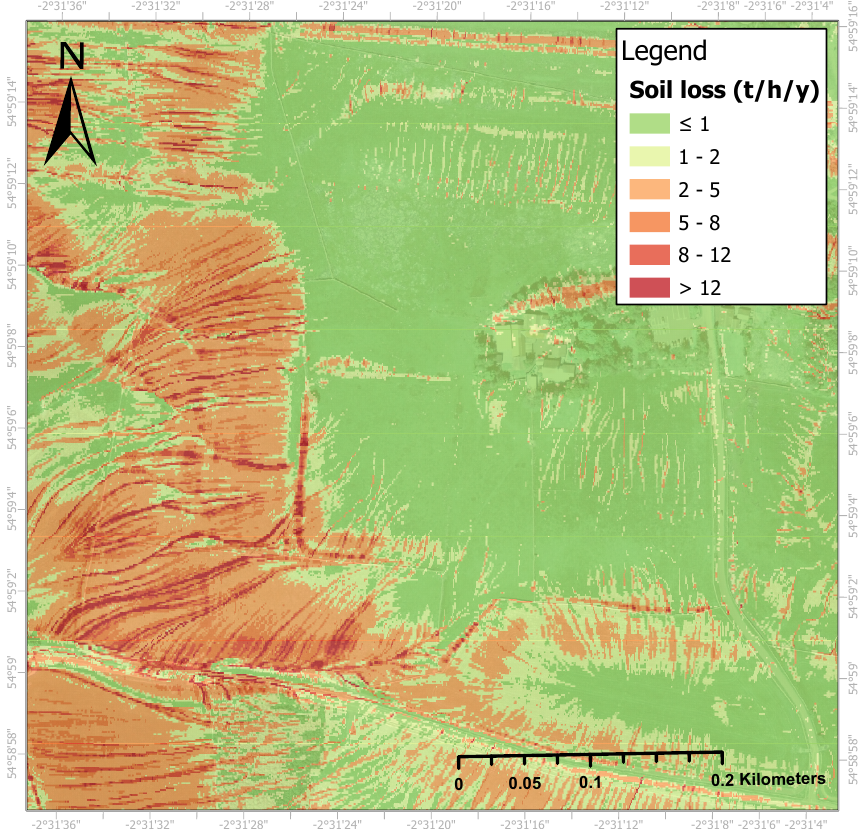
Figure 5. Annual soil loss (t/h/y) according to the RUSLE in the land surrounding Magna . (Map produced using ArcGIS Pro (version